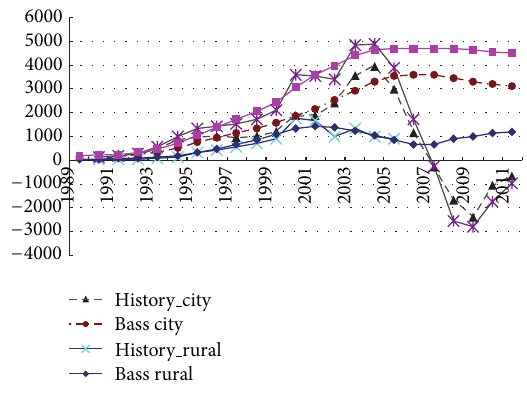
Figure 11: Plots of the diffusion rate of telephone by Bass